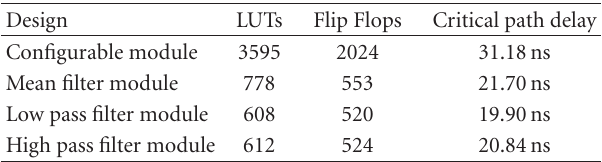
Table 2: Comparing resource use and critical path delay for reconfigurable module and specialized module.